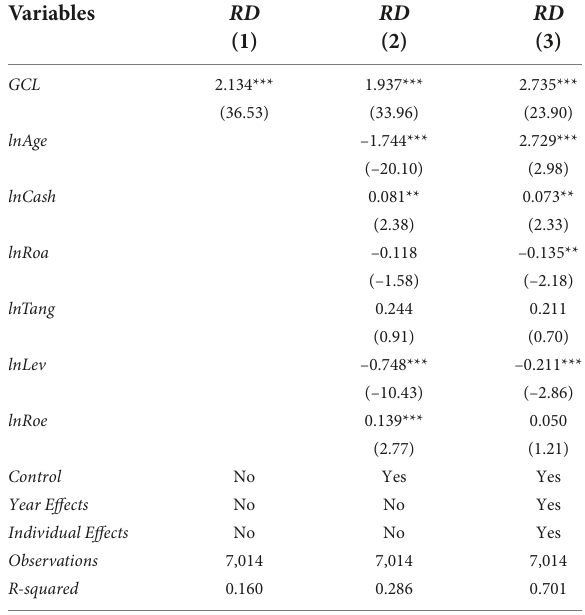
TABLE 3 Robustness tests I: substitution of explanatory